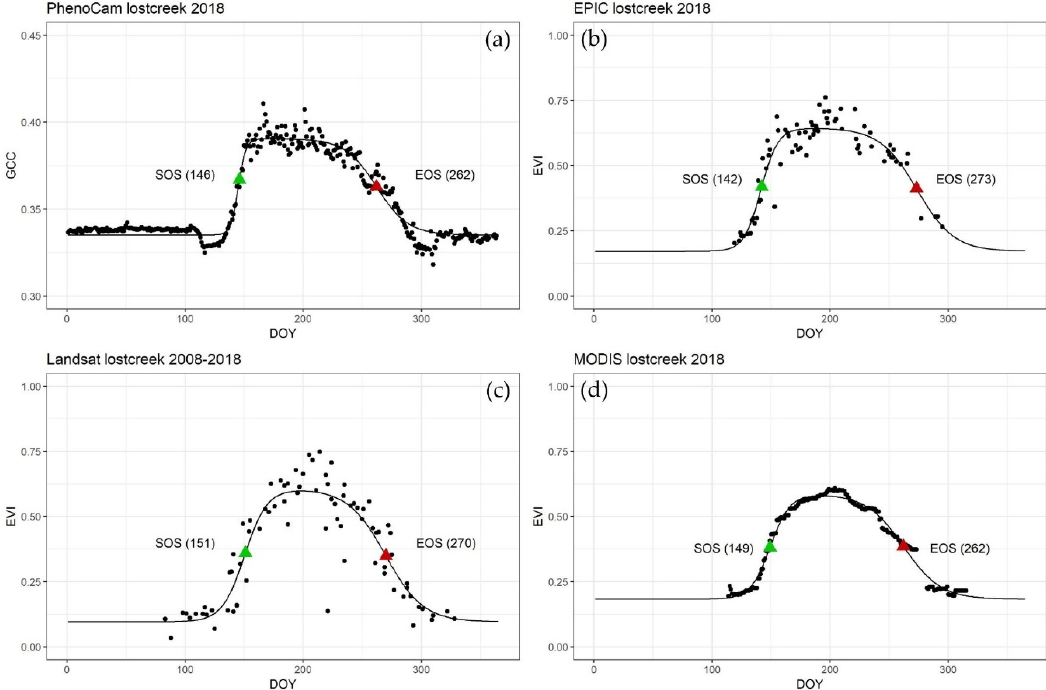
. Figure A5. Derived vegetation phenology indicators of SOS and EOS from EVI for wetland study site ‘lostcreek’ based on ( a ) PhenoCam, ( b ) EPIC, ( c ) Landsat, and ( d ) MODIS observations. The green triangles indicate SOS, and the red triangles indicate EOS for each time series. The y-axis scale was kept constant for Landsat, MODIS, and EPIC, but adjusted for PhenoCam to better show the shape of the curve.